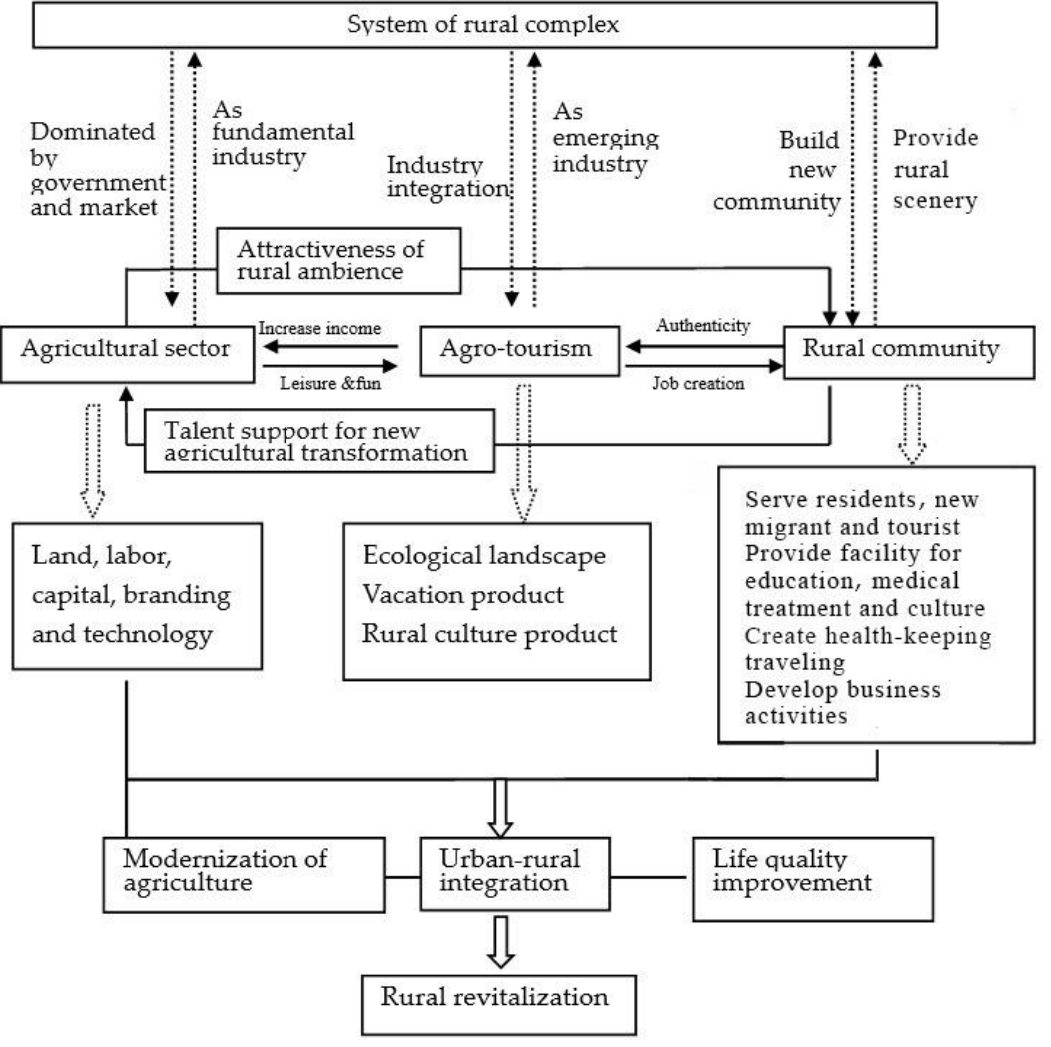
Figure 5. Structure platform of rural complex (Source: Drawn by the Authors).